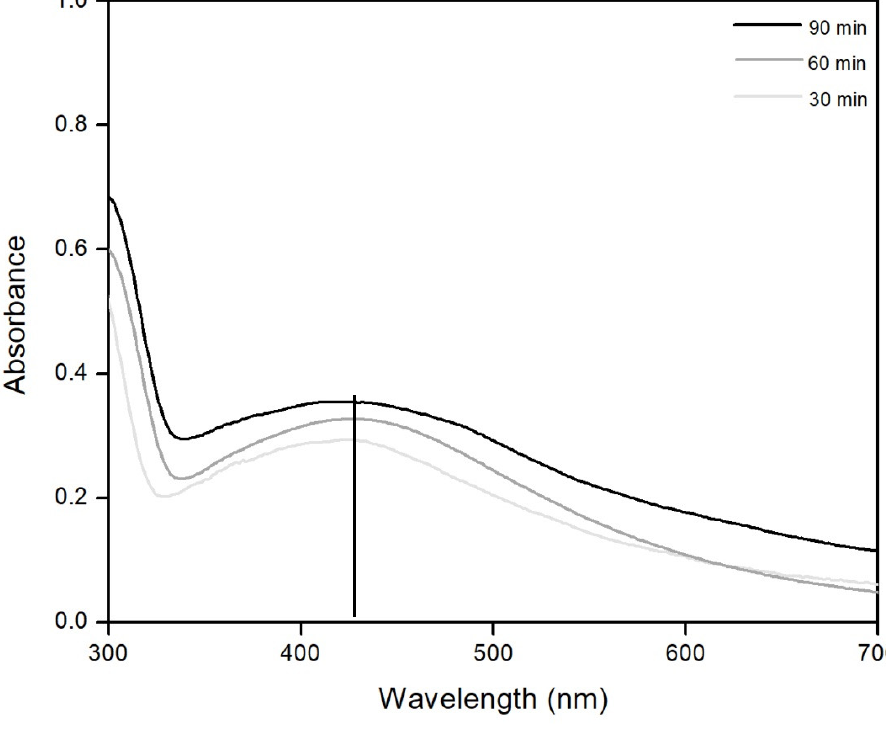
Figure 3. UV–VIS absorption spectra for different ultrasound times.